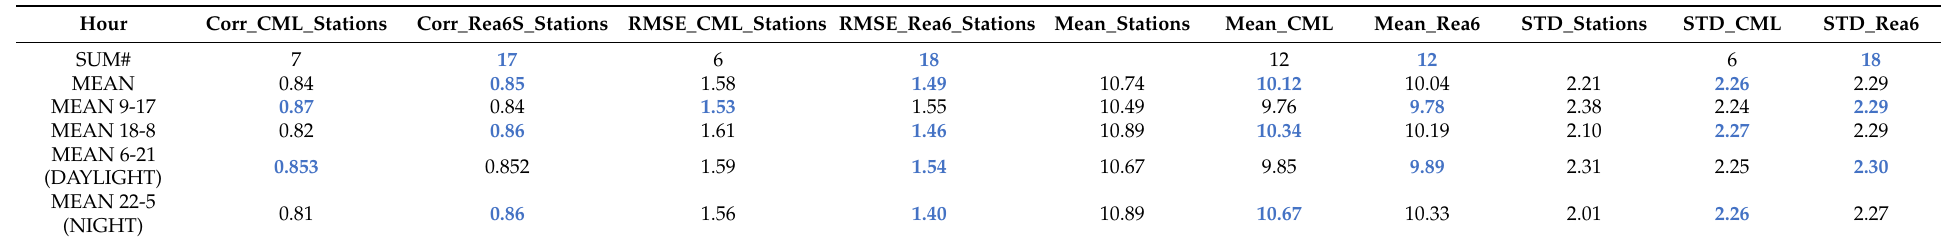
Table 2. Averaged correlation, RMSE, mean and STD based on the cali2 method and comparisons at all the WSs locations. A comparison between reanalysis (Rea6) and CML-HO (cali2) based on the comparison to WS-HO. The values represent the averages for the whole period (June 2018) for each hour of the day, separately. The number in the first row (SUM#) indicates on the better results for each observation source. Other rows summarized the mean for all the hours (second row) and for different parts of the day (numbers refer to the local time). The better method, i.e., CML or Rea6, is indicated in